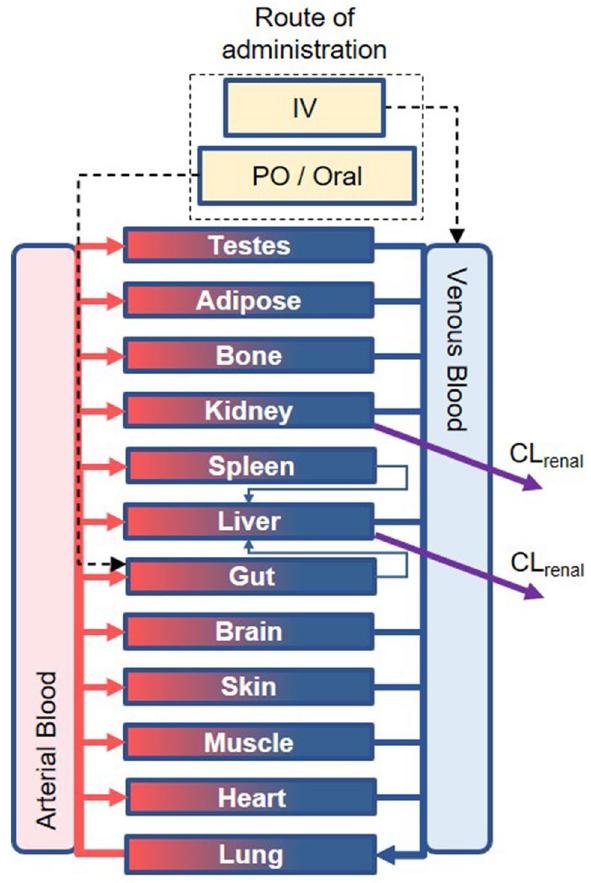
Figure 7. Overview diagram of the BIOiSIM mechanistic model. Note: some compartments are omitted for clarity. CL liver hepatic clearance, Cl renal renal